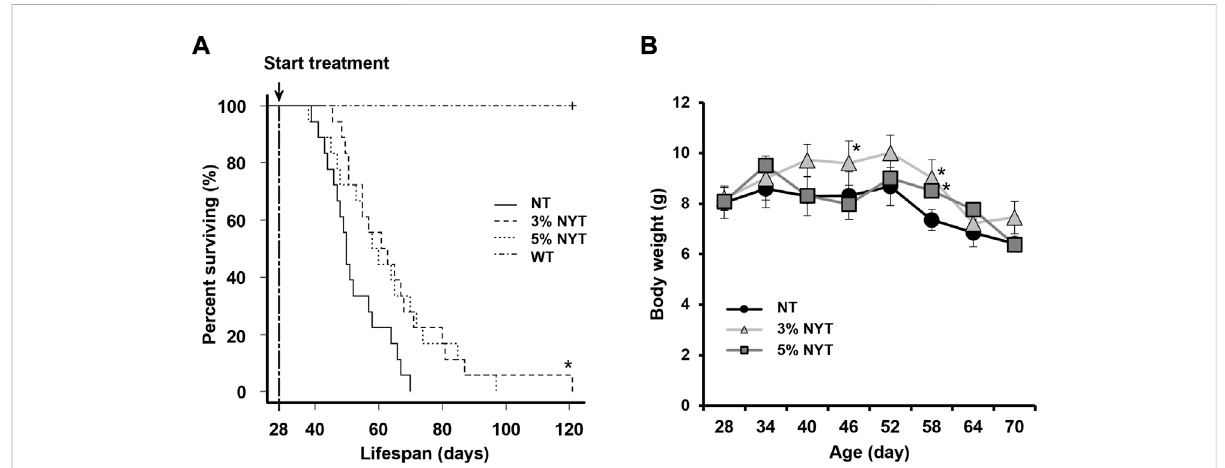
FIGURE 1 Survival rate and weight change with aging. Survival curves of Kaplan-Meier analysis are shown (A) . Treatment was started when the mice were 28 days old. Log-rank test was employed to detect signi fi cant differences (* p < 0.05, Bonferroni comparison, n = 18) Body weight (B) was measured every 6 days and is shown. Data are plotted as mean and SEM values. Signi fi cant differences are presented on histograms: (* p < 0.05, Dunnett ’ s